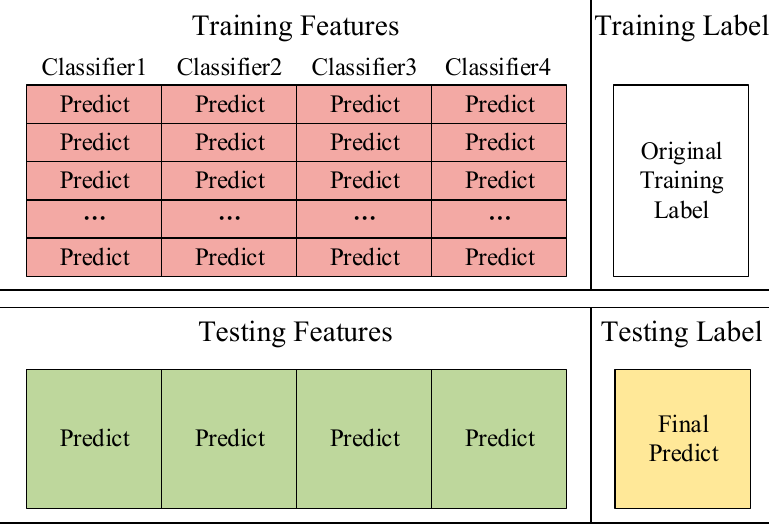
Figure 6. The composition of the new training set and test set.